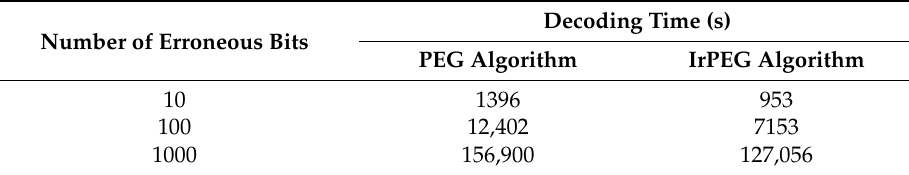
Table 1. Comparison of the decoding time of the E b / N 0 of Code1 at 3 dB.